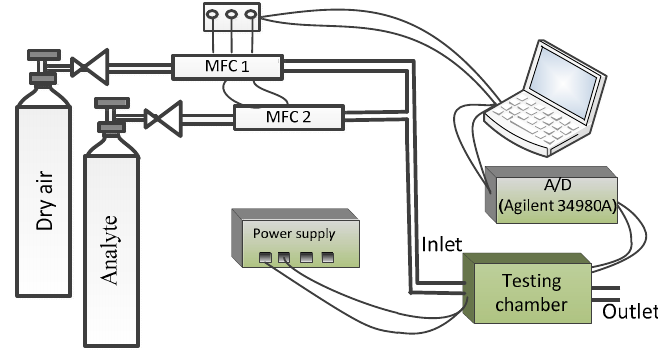
Figure 2. The experimental